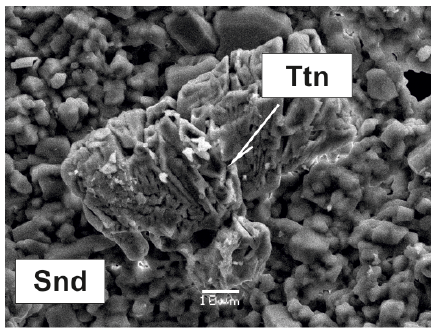
Figure 5. Split titanite crystals overgrowing sanidine crust. SE im-